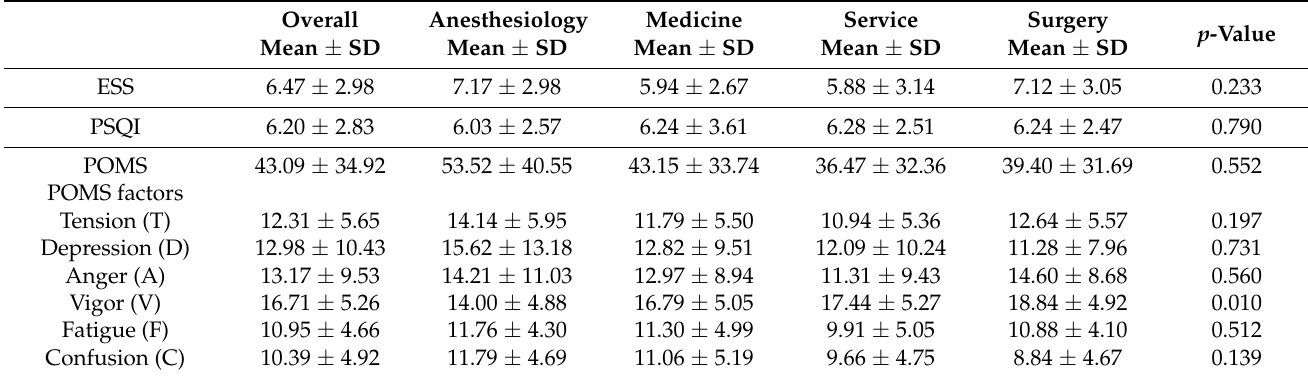
Table 3. Stratification of the results of ESS and PSQI questionnaires with respect to cut-off. Overall Anesthesiology Medicine Service Surgery